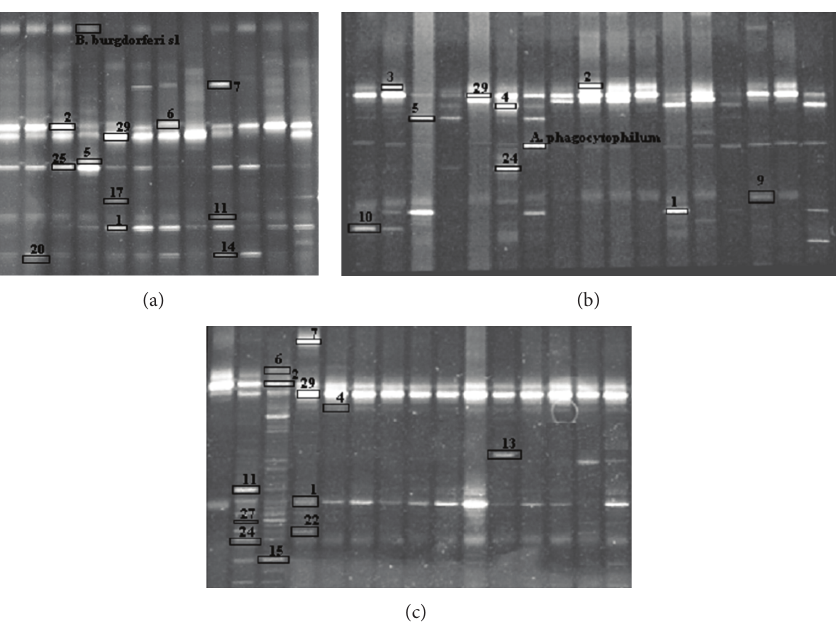
Figure 1: (a) SYBR Green-stained 16S rDNA DGGE profile of bacteria found in ticks from group G1. The DGGE bands have been identified in the figure with numbers corresponding to Table 2. Each lane represents one profile from a specific individual tick. Each band represents a specific bacterium. (b) SYBR Green-stained 16S rDNA DGGE profile of bacteria found in ticks from group G2. The DGGE bands have been identified in the figure with numbers corresponding to Table 2. Each lane represents one profile from a specific individual tick. Each band represents a specific bacterium. (c) SYBR Green-stained 16S rDNA DGGE profile of bacteria found in ticks from group G3. The DGGE bands have been identified in the figure with numbers corresponding to Table 2. Each lane represents one profile from a specific individual tick. Each band represents a specific